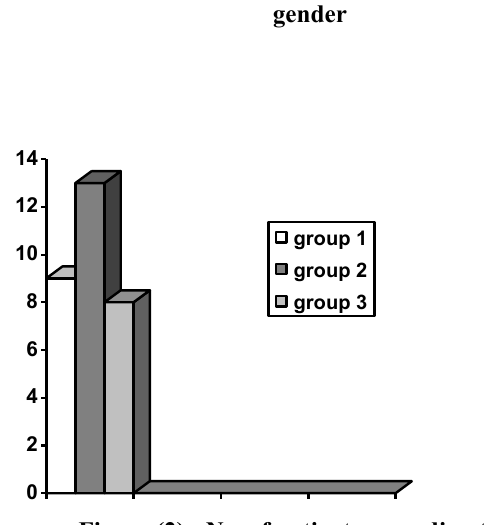
Figure (2) : No. of patients according to age group